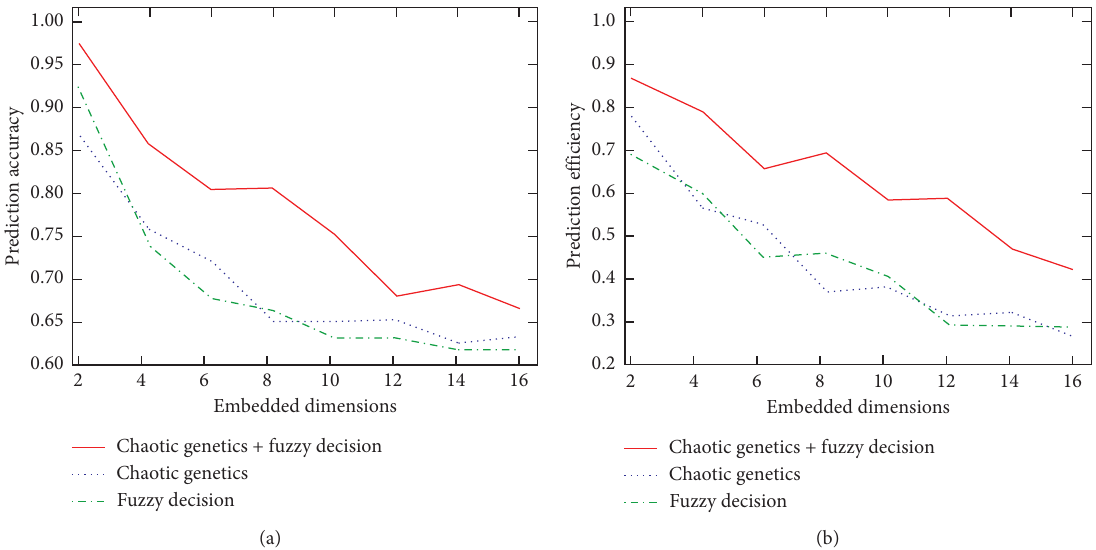
Figure 8: Relationship between embedded dimensions with prediction accuracy (a) and efficiency (b) with the three different algorithms,